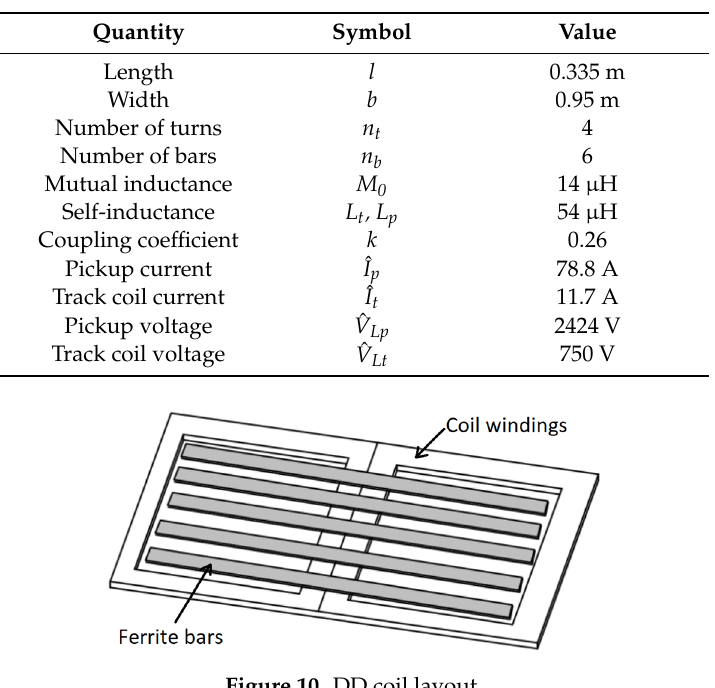
Table 2. Coupling set characteristics.